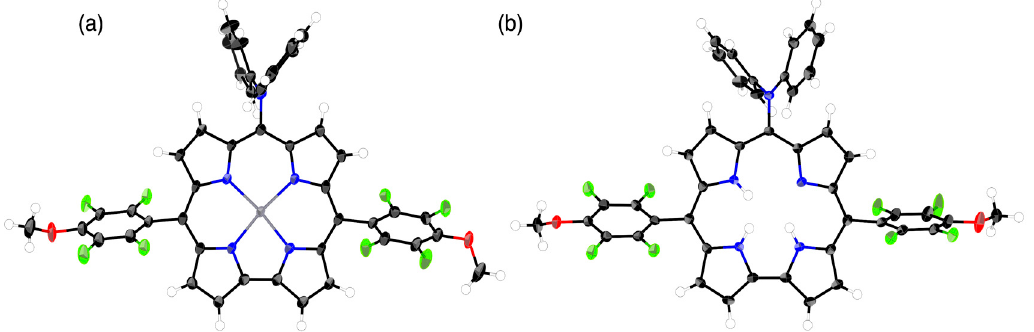
Figure 1. X-Ray crystal structures of (a) 6Ag and (b) 6H . The thermal ellipsoids were scaled to 50% probability. Solvent molecules were omitted for clarity.